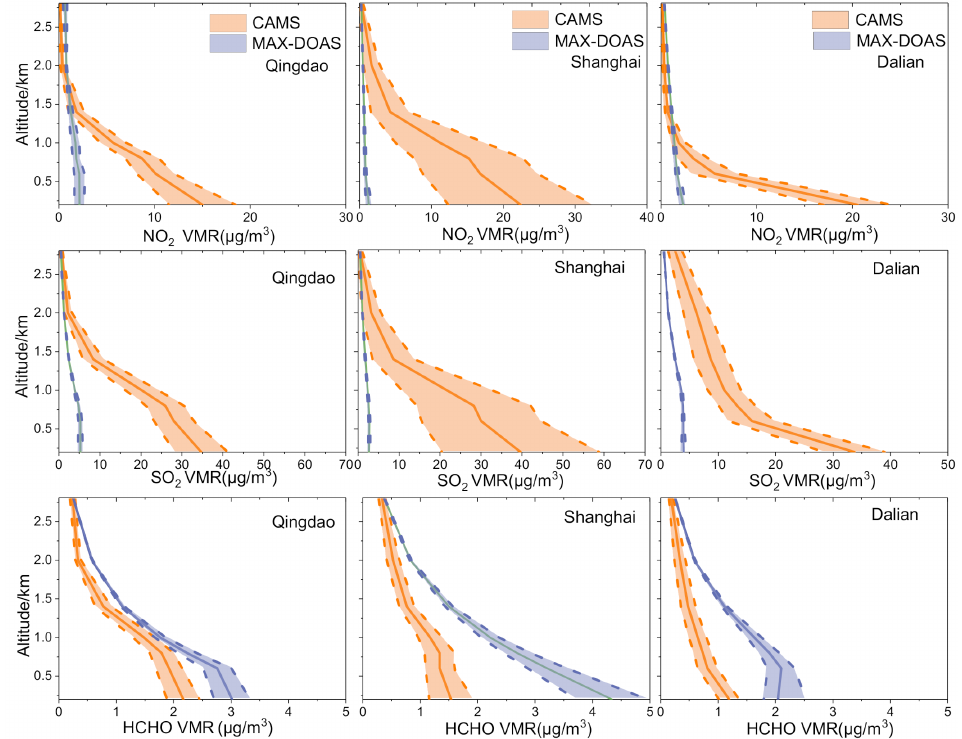
Figure 17. The NO 2 , SO 2 , and HCHO volume mixing ratios (VMR) derived from the CAMS model and MAX-DOAS observations in Qingdao, Shanghai, and